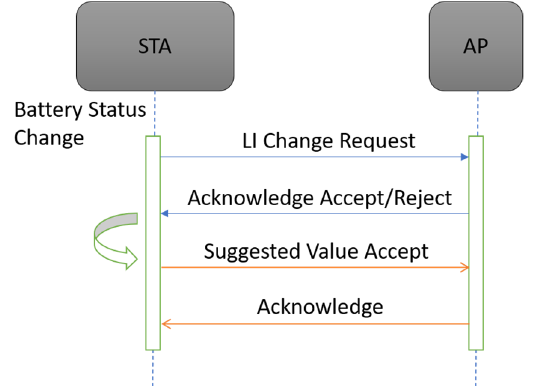
Figure 12. LI Change Sequence Diagram.